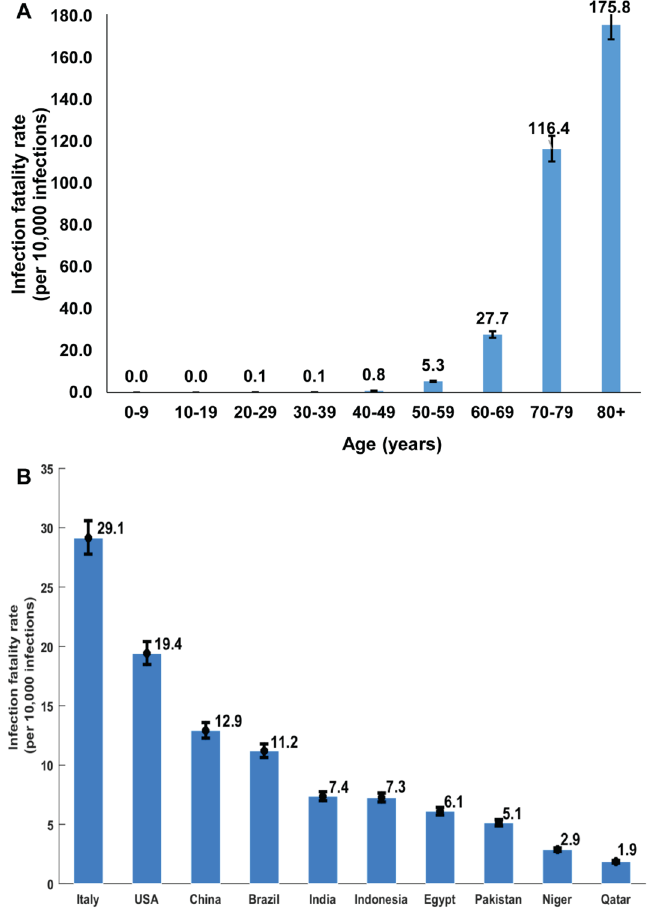
Figure 3. ( A ) The age-specific infection fatality rate in Qatar. ( B ) Estimated overall (total population of all age groups) infection fatality rate for several select countries that are characterized by diverse demographic structures. The estimates were generated by applying the Qatar-estimated age-specific infection fatality rate to the age structure of the population in each country. Population size and demographic age-structure of each country were extracted from the United Nations World Population Prospects database 22